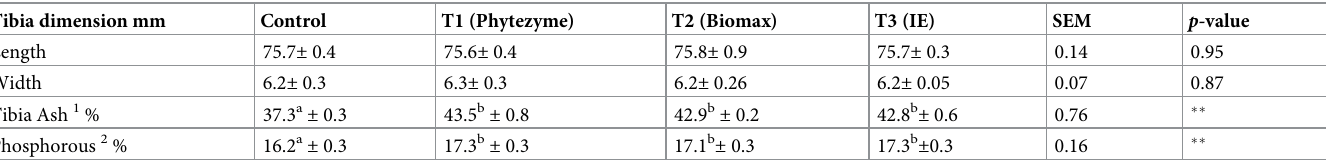
Table 4. Determination of tibia ash content in the broiler